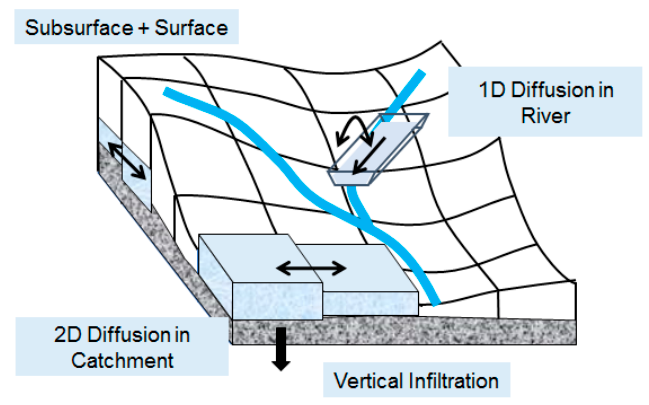
Figure 3. Schematic diagram of rainfall-runoff-inundation (RRI) model.